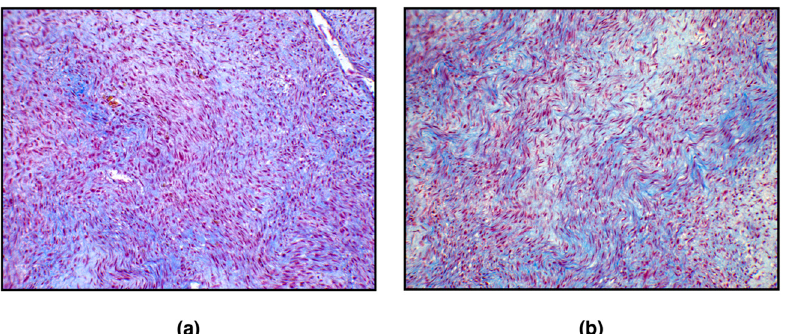
Figure 2. Leiomyoma, ovary, white tiger. Masson’s Trichrome (MT). (a) Smooth muscle cell cyto- plasm was stained red (magnification, 200×); (b) abundant, thin, blue-stained collagen bundles in- tersect between individual neoplastic cells (magnification, 200×).